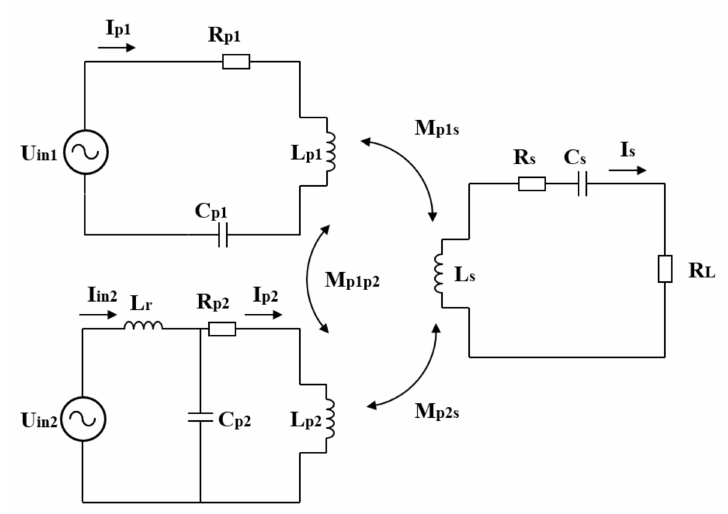
Figure 3. S-S and LCL-S compound resonant compensation